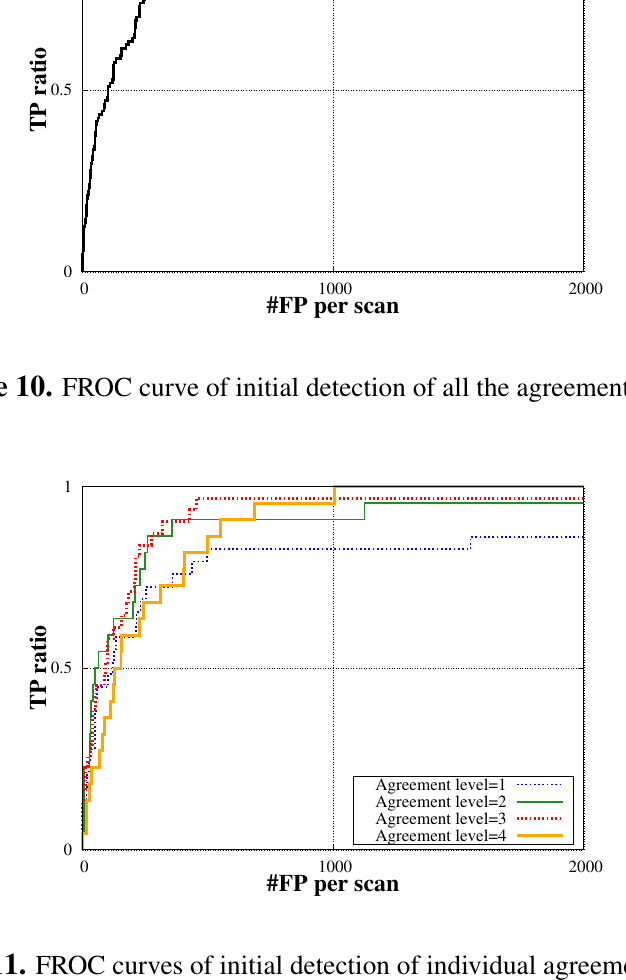
Figure 11. FROC curves of initial detection of individual agreement